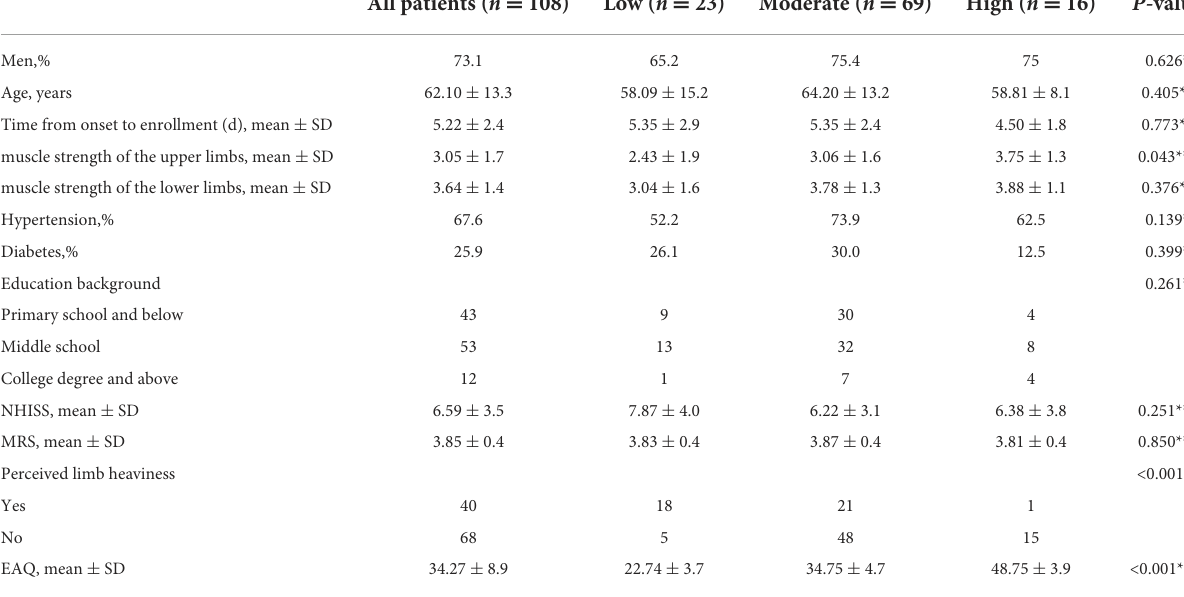
TABLE 1 Stratification of baseline characteristics by the outcome and rehabilitation adherence level.